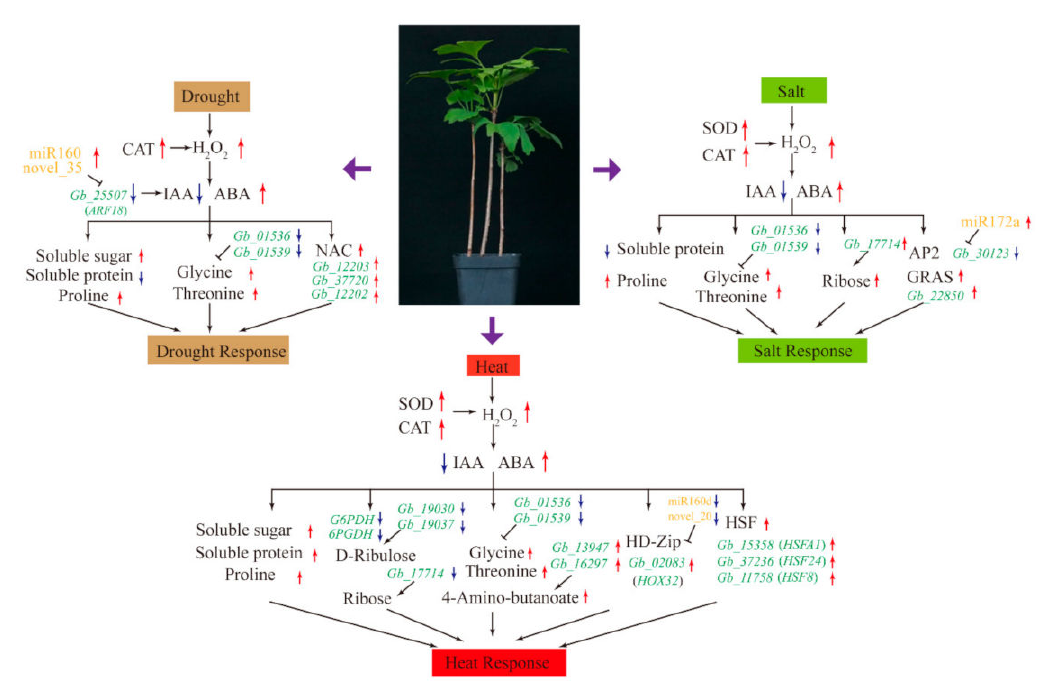
Figure 8. Schematic diagram of stress responses, showing major changes in physiology, biochemistry, metabolism, and transcription. Red and blue represent upregulation and downregulation, respectively. CAT: Catalase; SOD: Superoxide dismutase; ABA: Abscisic acid; IAA: Indole-3-acetic acid; NAC: NAC transcription factor; HSF: Heat shock transcription factor.